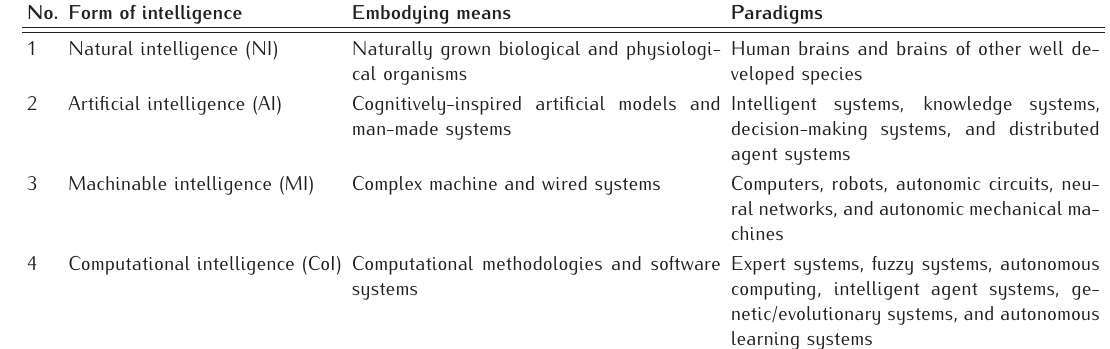
Table 1. Taxonomy of Abstract Intelligence and its Embodying Forms.